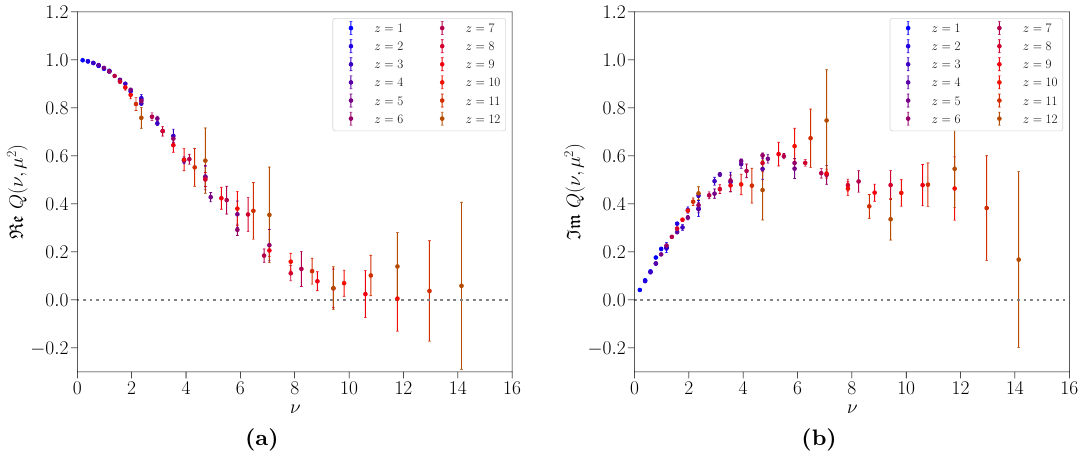
Figure 7. (a) Real and (b) imaginary component of the unpolarized ITD at a scale of 2 GeV in MS obtained from the matching relation (4.1), where a smooth and continuous description of the M (cid:0) ν, z 2 (cid:1) data is provided by a polynomial fit for each z 2 . Data are shown for Wilson line extents z/a ≤ 12 ; extents z/a > 12 are considerably uncertain, and thus excluded from our ensuing